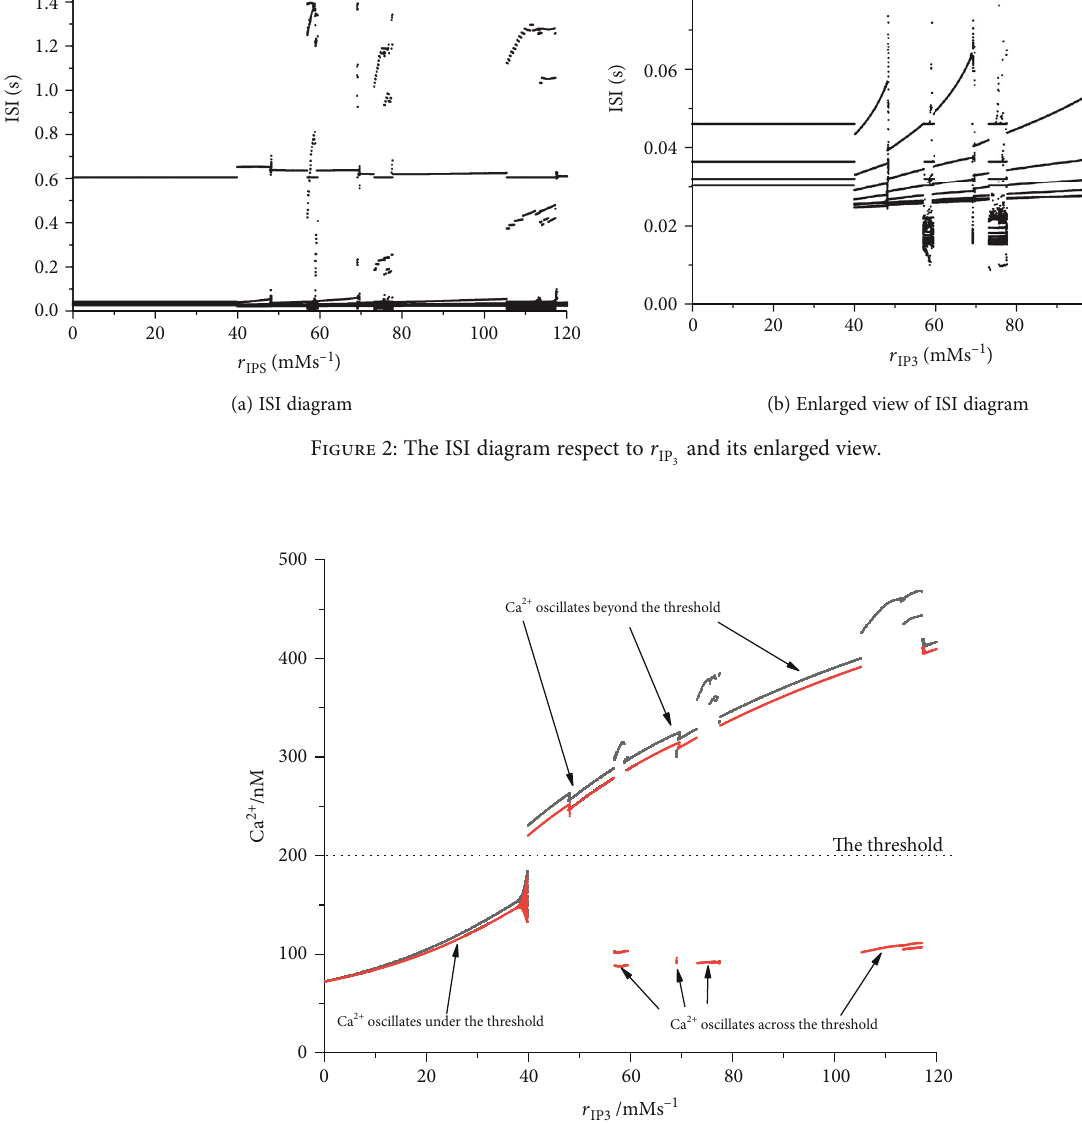
. Black dots denote the crest, and red ones are troughs of IP 3